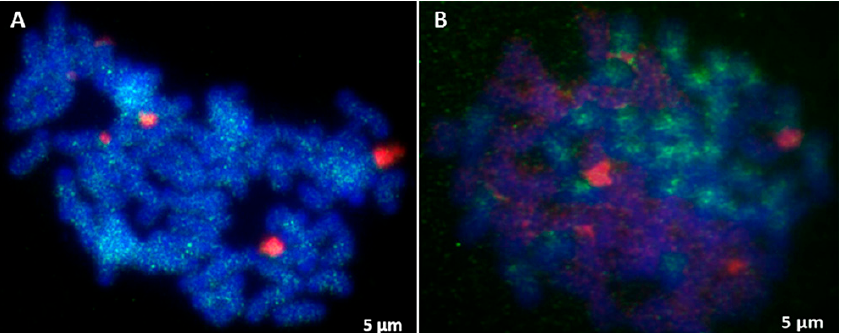
Figure 4. FISH result of clone Ea086 and 45S rDNA. ( A ) HN92-77; ( B ) YCE96-40. The probe of clone Ea086 was labelled with Dig (Green), the probes of both 45S rDNA and Badila gDNA were labelled with Biotin (Red), chromosomes were counterstained with DAPI (Blue). Scale bars = 5 μ m.